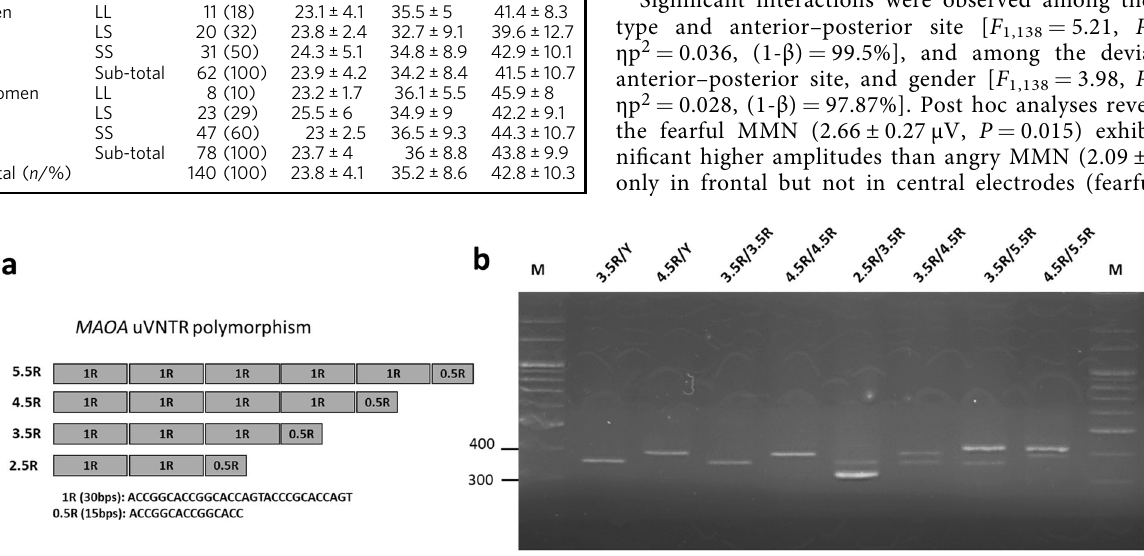
Fig. 1 Genotyping of the MAOA-uVNTR polymorphism. a This diagram shows MAOA-uVNTR alleles 2.5 R, 3.5 R,4.5, and 5.5 R. 1 R of each MAOA-uVNTR allele consisted of a 30 bp, and the 0.5 R consisted of a 15 bp. b The representative image of MAOA-uVNTR genotypes in 3% agarose gel. Lanes 1 and 2 are 3.5 R/Y and 4.5 R/Y from men; lanes 3, 4, 5, 6, 7 and 8 are 3.5 R/3.5 R, 4.5 R/4.5 R, 2.5 R/3.5 R, 3.5 R/4.5 R, 3.5 R/5.5 R, and 4.5 R/5.5 R from women, respectively. Electropherogram of alleles showing 2.5, 3.5, 4.5 and 5.5